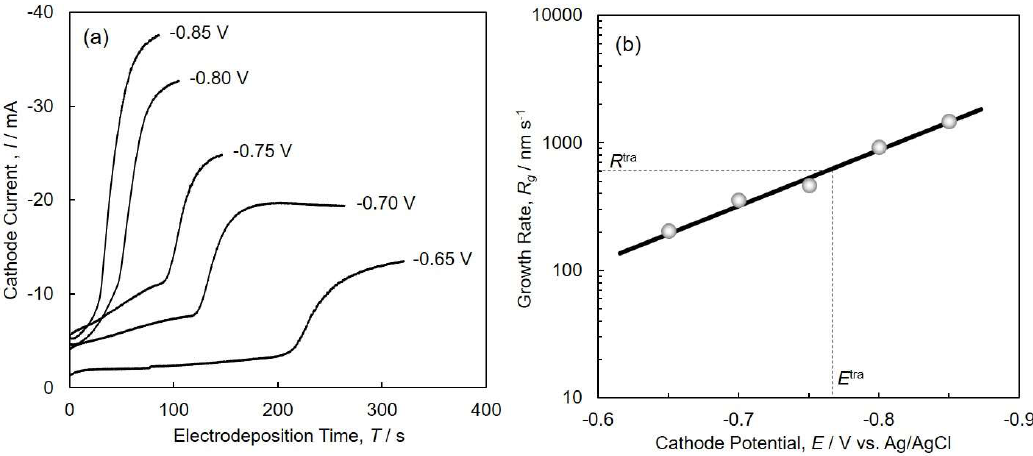
Figure 5. ( a ) Time-dependence of cathode current during the electrodeposition of Co nanocrystals in the nanochannels of anodized aluminum oxide templates. ( b ) Effect of cathode potential on the growth rate of electrodeposited Co nanocrystal arrays.